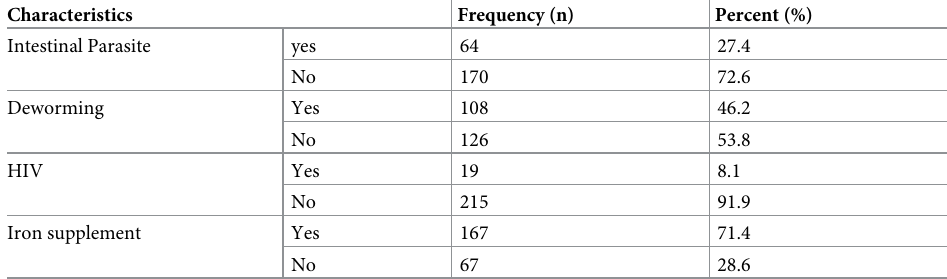
Table 5. Clinical factors among pregnant women attending antenatal care at Debre Markos Referral Hospital, Northwest Ethiopia, 2016. Characteristics